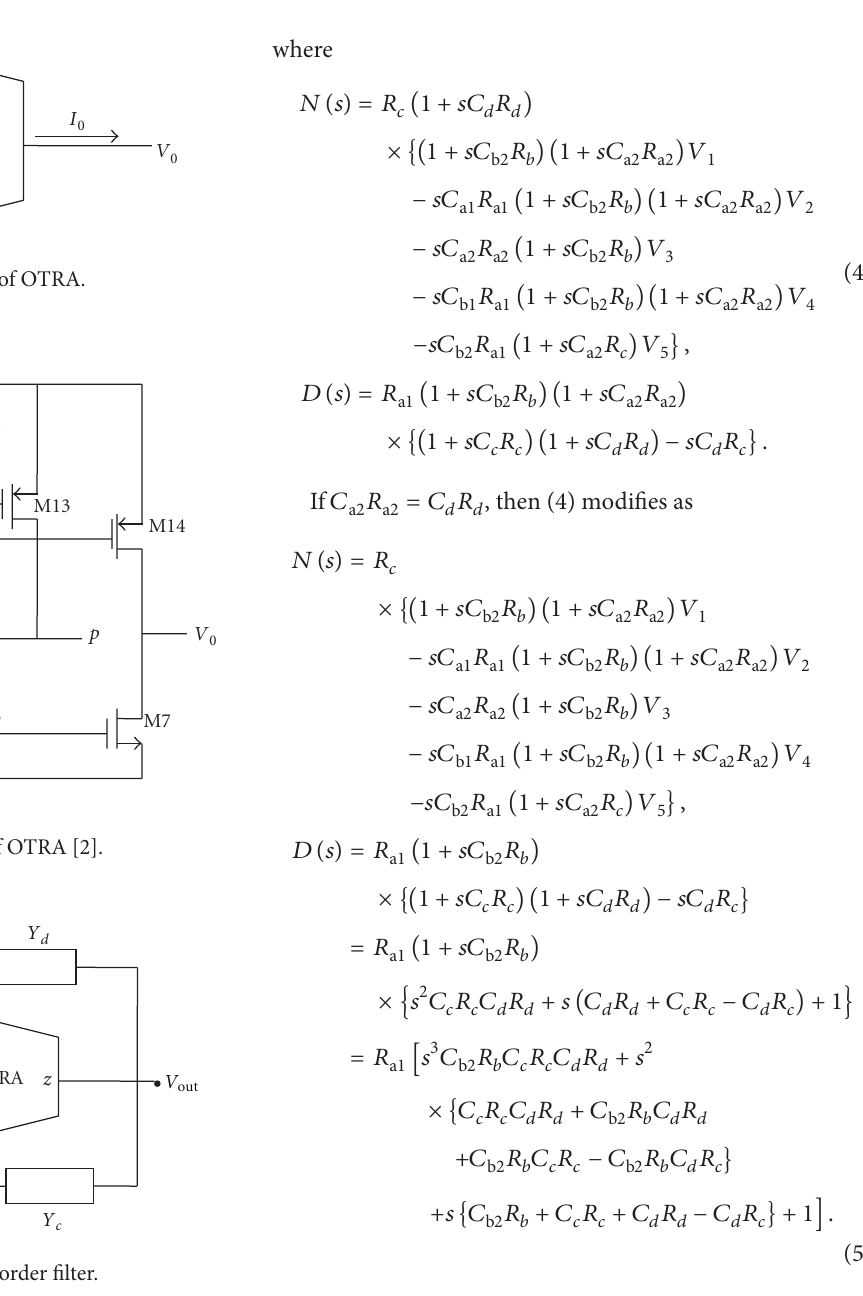
F 3: Generalized n th order �lter.